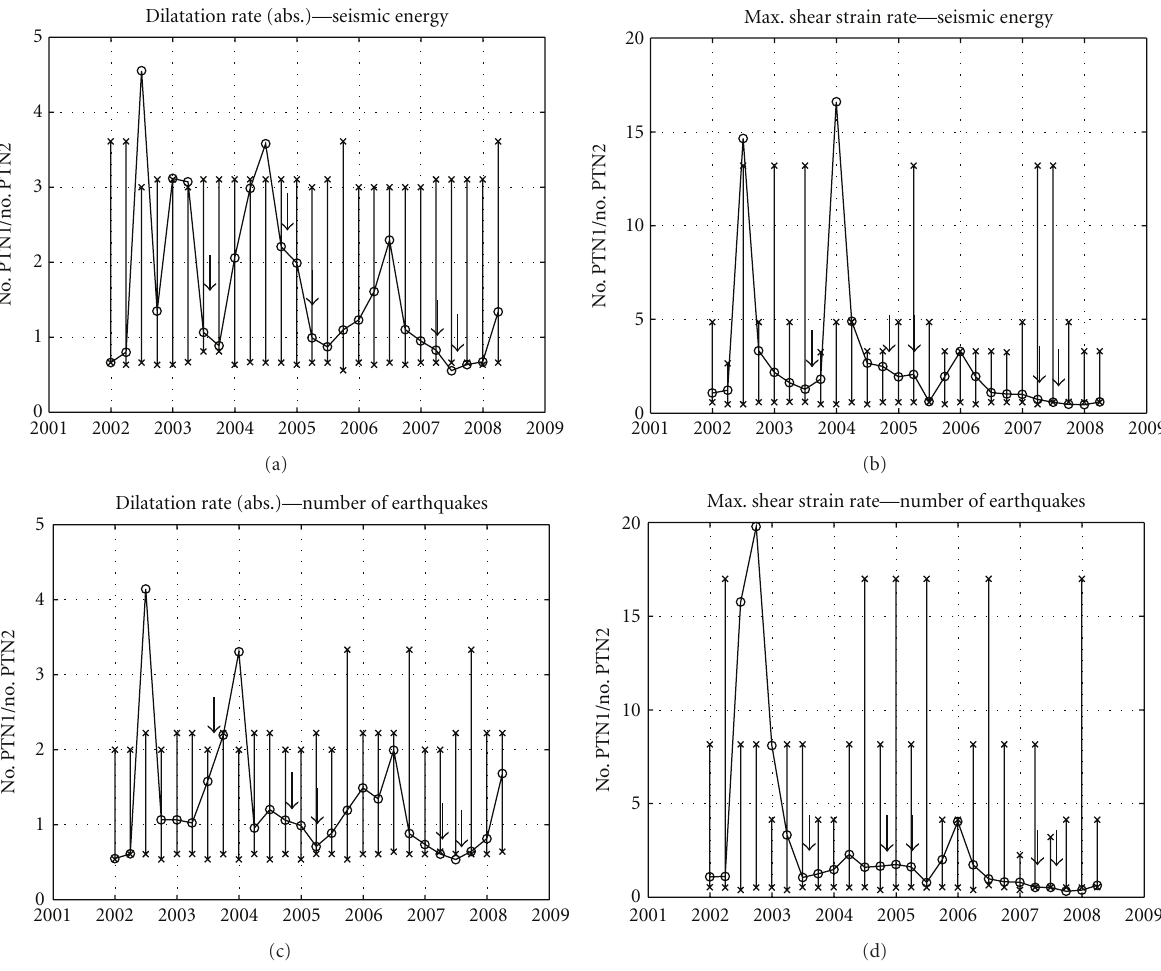
Figure 5: Temporal variation in the ratio of no. PTN1 to no. PTN2 (ref. Figure 3). Black arrows and the horizontal axis denote the same parameters as in Figure 4. Also shown are the error bars which were obtained by calculating the ratio between no. PTN1 and no. PTN2 shu ffl ed in Figure 4. Panels (a) to (d) correspond to di ff erent four pairs of geodetic and seismic quantities, which are the same as those in Figures 3 and